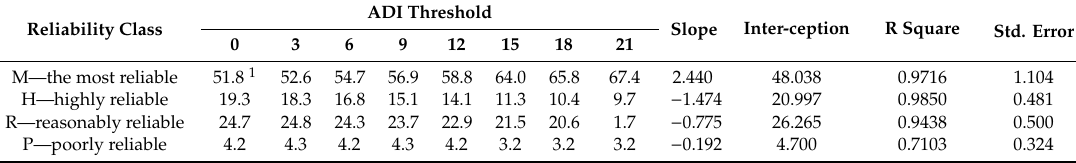
Table 7. Summarisation of the ADI threshold values and linear trends